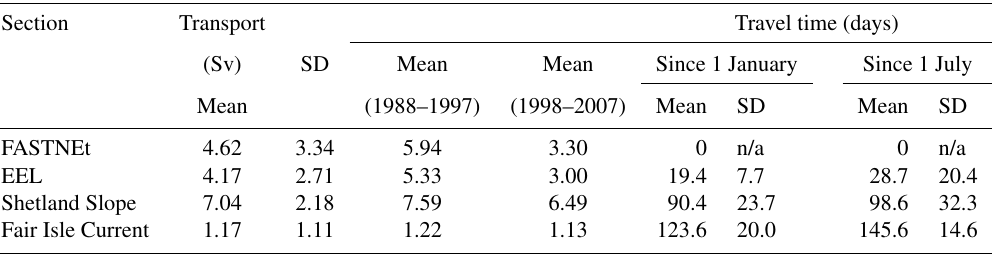
Table 1. Long-term mean and standard deviation (SD) of transport, decadal means for 1988–1997 and 1998–2007, and corresponding age statistics at the three selected sections along the continental shelf break, and across the Fair Isle Current branch of Atlantic inflow to the northwest North Sea (positive southward). The FASTNEt section extends from 9.74 ◦ W, 55.82 ◦ N (1516m) to 9.28 ◦ W, 55.79 ◦ N (181m). The EEL section extends from 9.48 ◦ W, 57.11 ◦ N (1046m) to 8.57 ◦ W, 57.05 ◦ N (120m). The Shetland Slope section extends from 2.72 ◦ W, 60.87 ◦ N (412m) to 2.15 ◦ W, 60.57 ◦ N (133m). The Fair Isle Current is associated with flow between 1.1 and 2.46 ◦ W at 59.27 ◦ N, approximately the western portion of the JONSIS line.